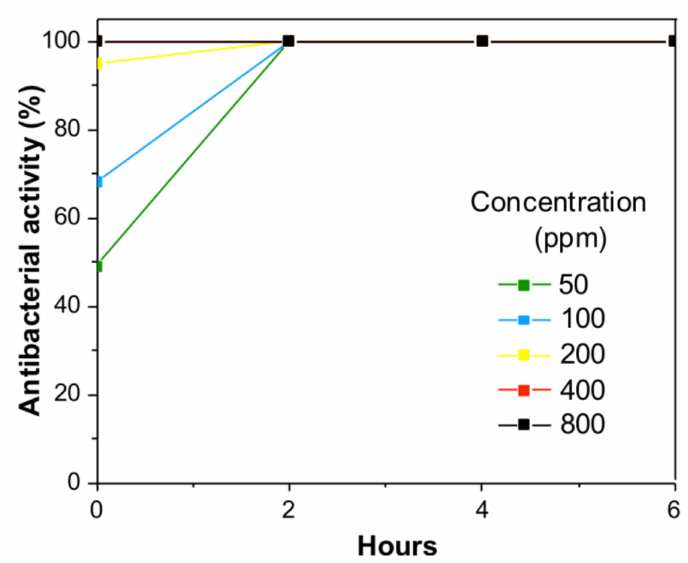
Figure 8. Percentage of the antibacterial activity of the Cu-PEI/AABT NPs against P. aeruginosa at different concentrations.